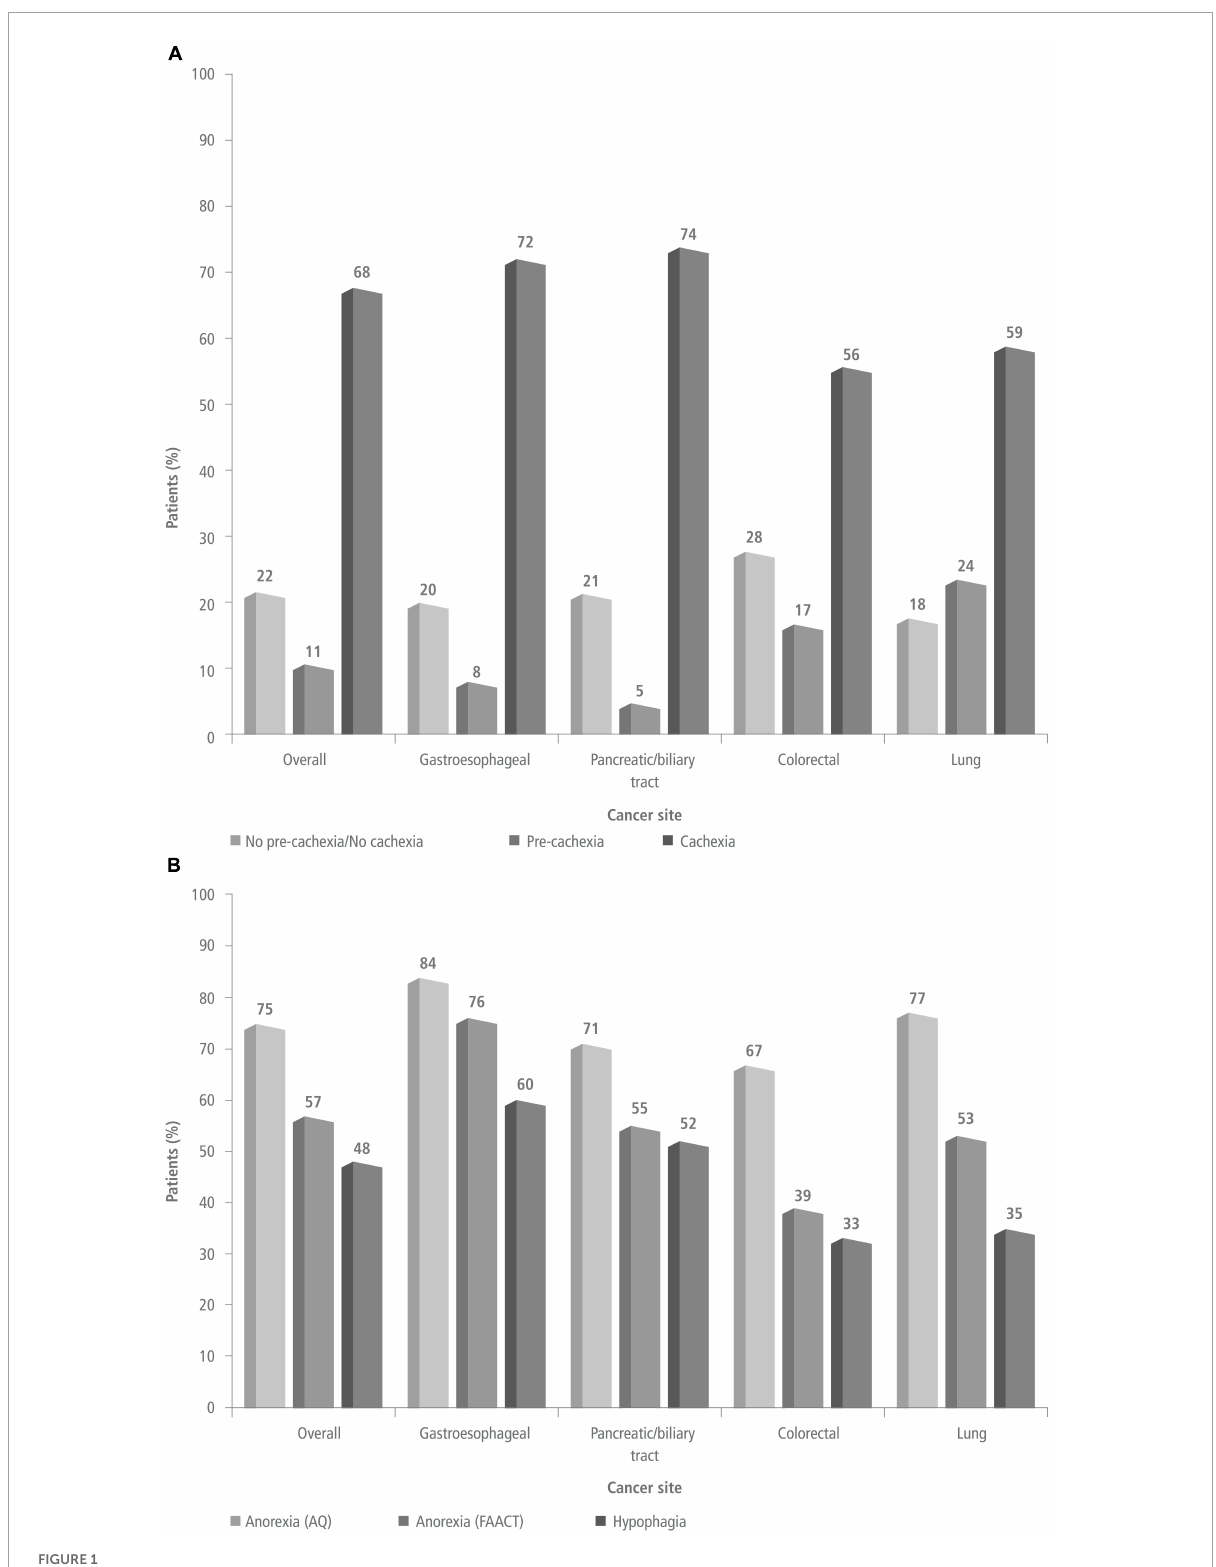
FIGURE1 Prevalence of pre-cachexia/cachexia [panel (A) ] and prevalence of anorexia and hypophagia [panel (B) ] at the time of diagnosis in the overall study population and by cancer site. AQ, anorexia questionnaire; FAACT, functional assessment of anorexia/cachexia therapy.